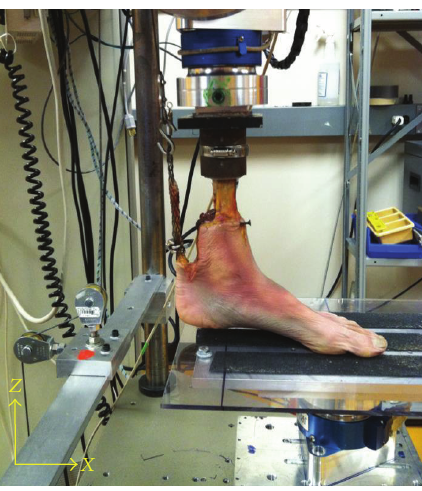
Figure 3: Specimen mounted in the RTP. This image shows clearance between the heel and 𝑋 - 𝑌 table as the AT load is applied, allowing unconstrained arch formation.